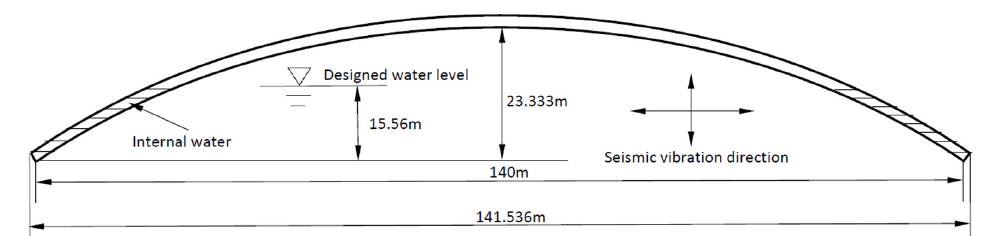
Figure 5. Sketch of the geometry of the arch rib.